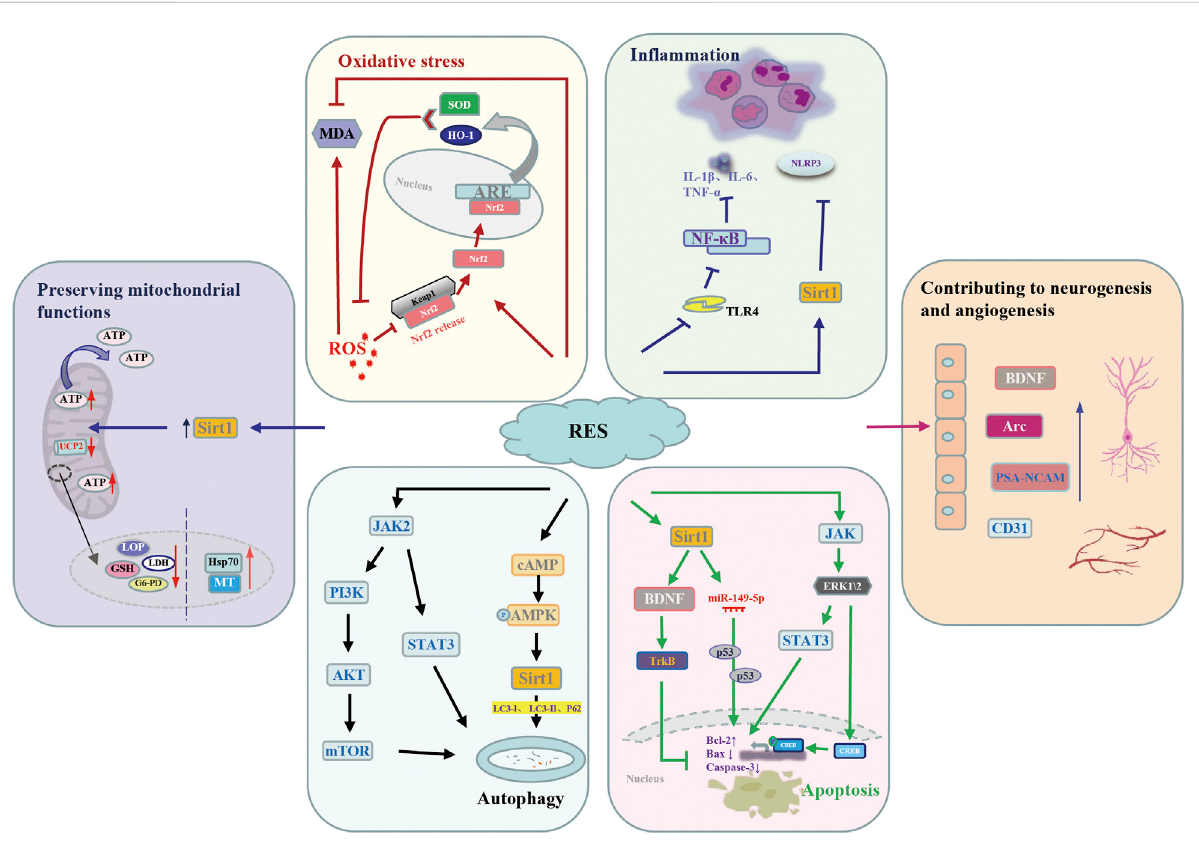
FIGURE 8 Potential molecular mechanisms underlying the neuroprotective action of resveratrol against cerebral I/R injury. AMPK, AMP-activated protein kinase; Arc, Activity-regulated cytoskeleton-associated; ARE, antioxidant response element; Bax, bcl-2-associated x; Bcl-2, b-cell lymphoma-2; BDNF, brain derived-nerve neurotrophic factor; CD31, platelet and endothelial cell adhesion molecule 1; CREB, cyclic-AMP response element binding protein; ERK, extracellular signal-regulated kinases; G6-PD, glucose 6-phosphate dehydrogenase; GSH, glutathione; HO-1, heme oxygenase 1; Hsp70, heatshockprotein70; IL-1 β , interleukin-1beta; IL-6, serum interleukin-6; JAK, janus kinases; Keap l, Kelch-like ECH-associated protein 1; LC3, light chain 3; LDH, lactate dehydrogenase; LPO, lipid peroxidation; MDA, malondialdehyde; MT, metallothionein; mTOR, mammalian target of rapamycin; NF- κ B, nuclear factor- κ B; NLRP3, NOD-like receptor thermal protein domain associated protein 3; Nrf2, nuclear factor erythroid 2-related factor 2; p62, sequestosome-1; PI3K, phosphoinositide 3-kinase; PSA-NCAM, Polysialylated-Neural Cell Adhesion Molecule; RES,resveratrol;ROS,reactiveoxygenspecies;Sirt1,silent mating typeinformation regulation 2homolog1;STAT3,signal transducersandactivators of transcription 3; SOD, superoxide dismutase; TrkB, tyrosine kinase receptor B; TLR4, Toll-like receptor 4; TNF- α , tumor necrosis factor- α ; UCP2, uncoupling protein